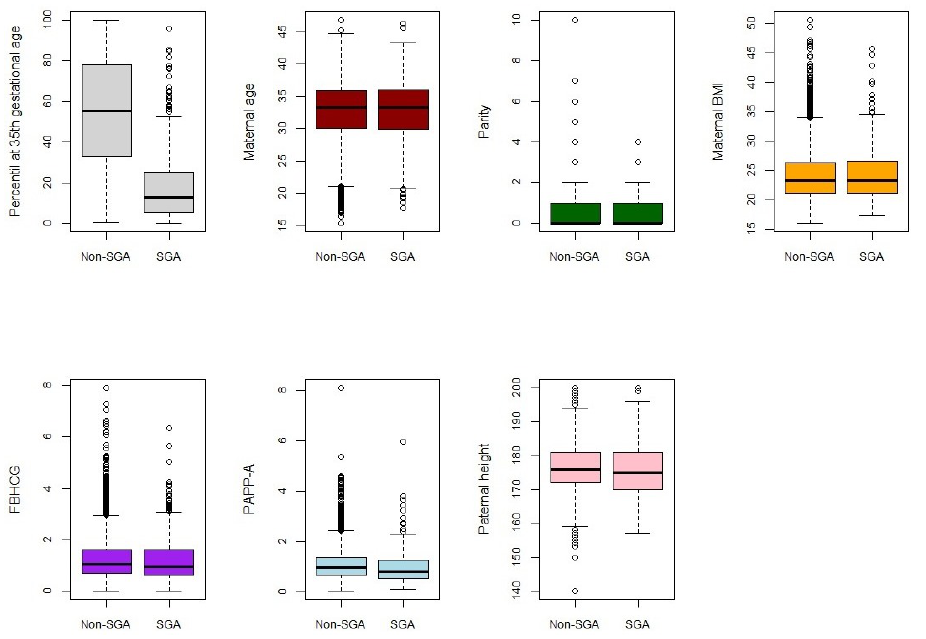
Figure 2. Information from SGA dataset.